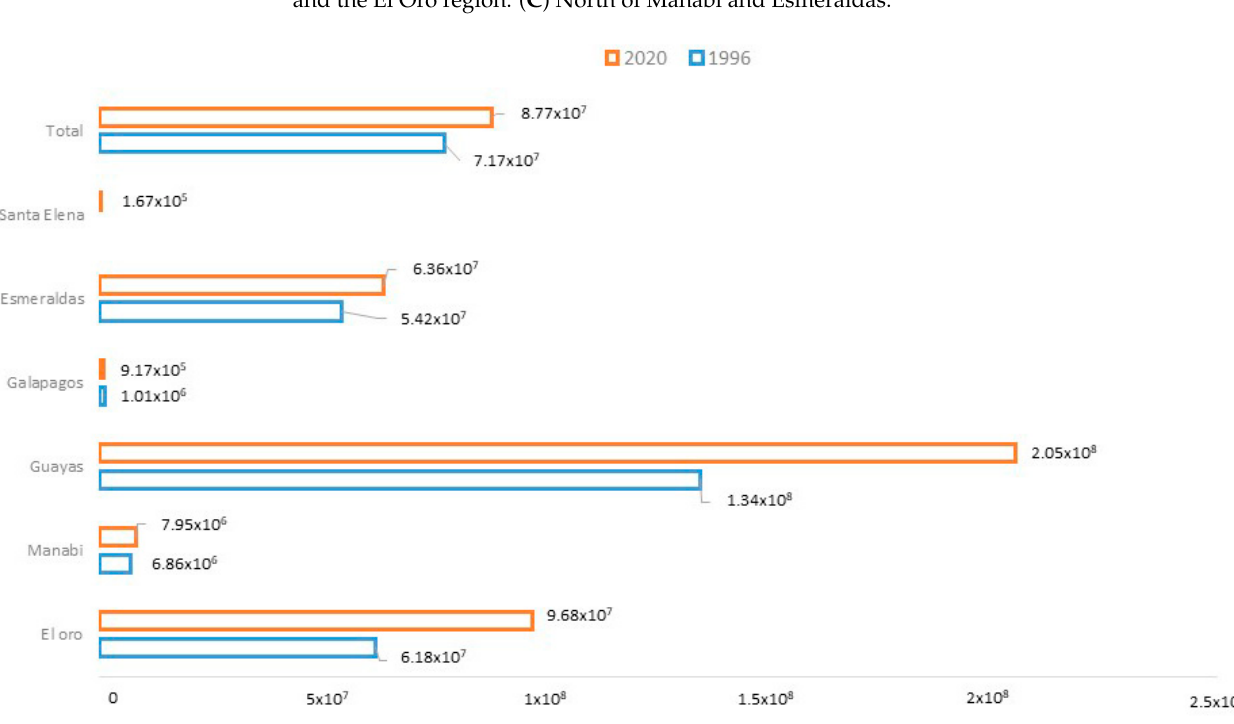
Figure 7. Average connectivity of mangrove forests per patch in the years 1996 and 2020 by prov- ince.